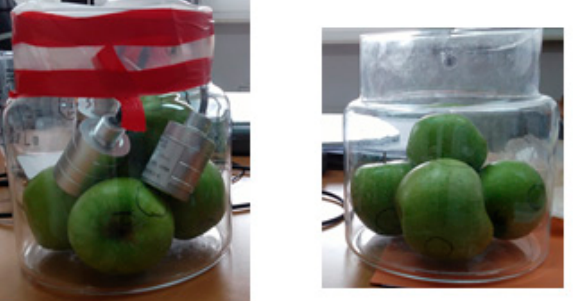
Figure 2. Optical micrographs of ( a ) neat LDPE, ( b ) LDPE + 10 wt % RH, ( c ) LDPE + 20 wt % RH, ( d ) LDPE + 30 wt % RH, ( e ) LDPE + 40 wt % RH and ( f ) LDPE + 50 wt % RH.